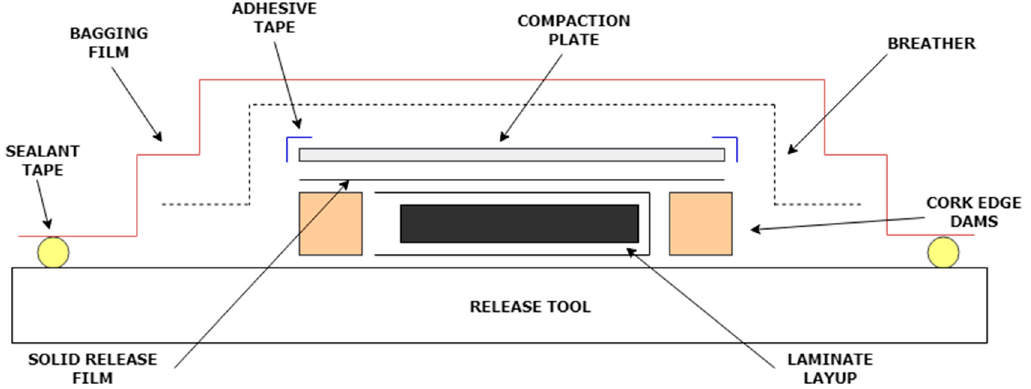
Figure 2. Schematic showing out-of-autoclave (OOA) tooling for ultra-thin laminates.